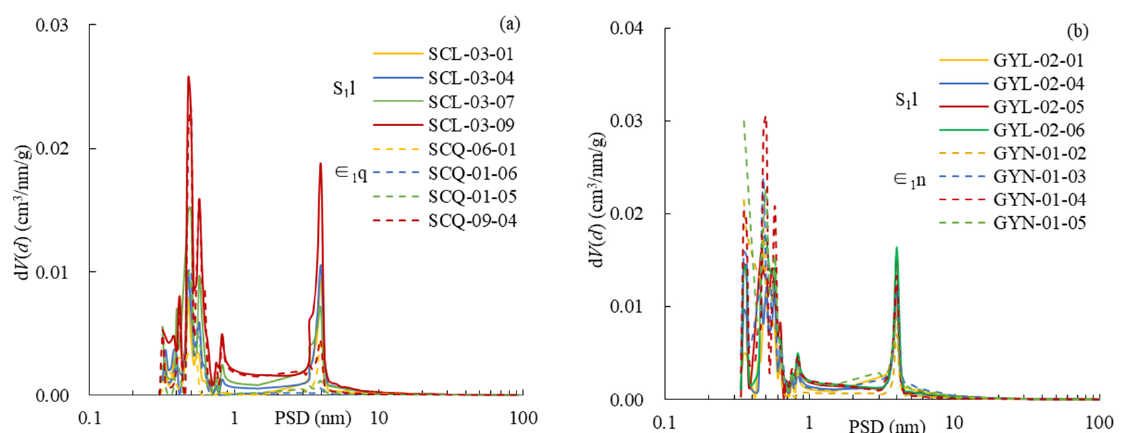
Figure 10. PSD curves of the Lower Paleozoic shale based on CO 2 and N 2 adsorption experiments in southern Sichuan Basin ( a ) and northern Guizhou province ( b ). (S 1 1 = the Lower Silurian Longmaxi Fm, ∈ 1 q = the Lower Cambrian Qiongzhusi Fm, ∈ 1 n = the Lower Cambrian Niutitang Fm).